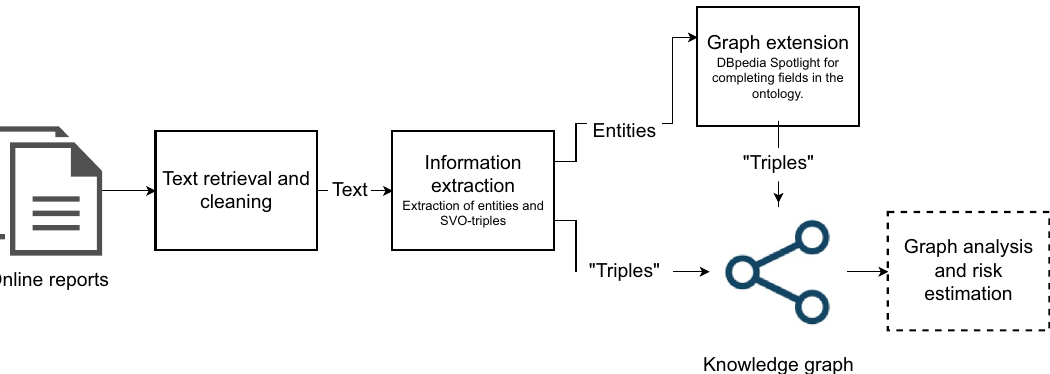
Figure 1. Process pipeline of the proposed knowledge mining framework. The framework and the modules are depicted as boxes with the correct order. The pipeline retrieves, cleans and extracts information